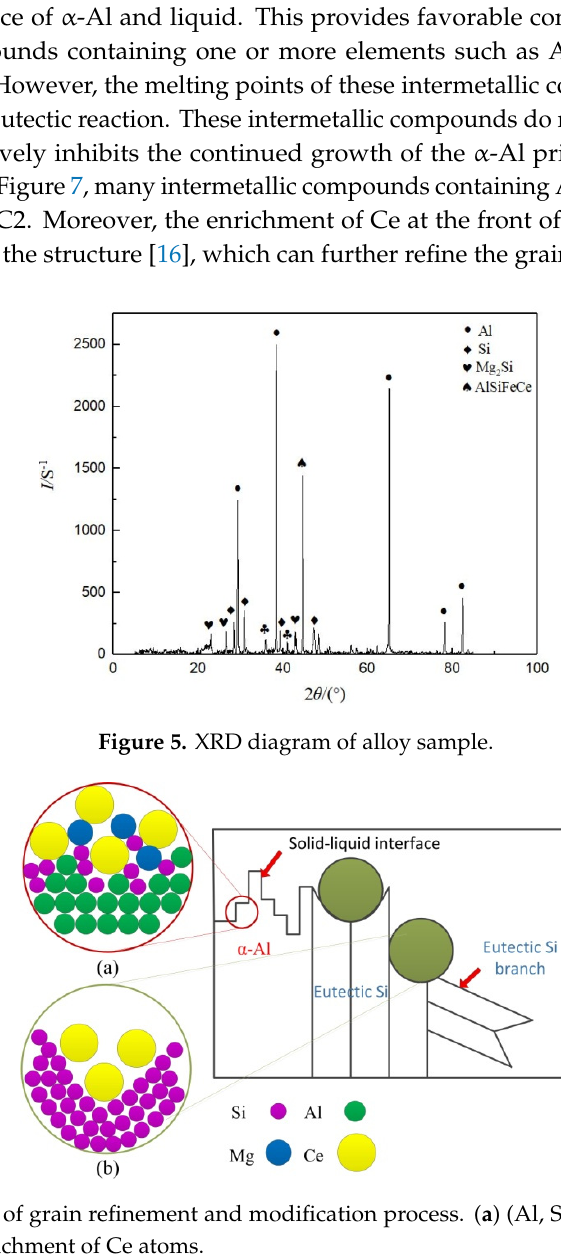
Figure 5. XRD diagram of alloy sample.